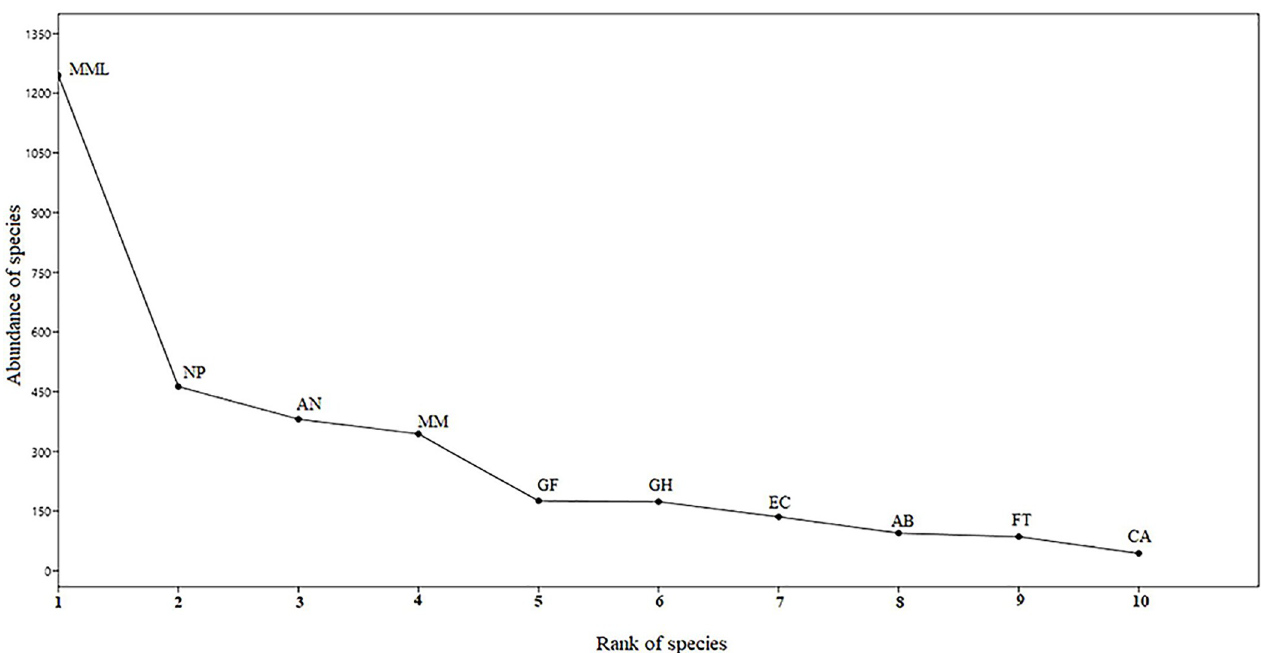
Fig 2. Rank abundance of ten dominant species / sub-species in the study area. MML: Milvus migrans lineatus; NP: Neophron percnopterus; AN: Aquila nipalensis , MM: Milvus migrans , GF: Gyps fulvus ; GH: Gyps himalayensis ; EC: Elanus caeruleus ; AB: Accipiter badius ; FT: Falco tinnunculus ; CA: Circus aeruginosus